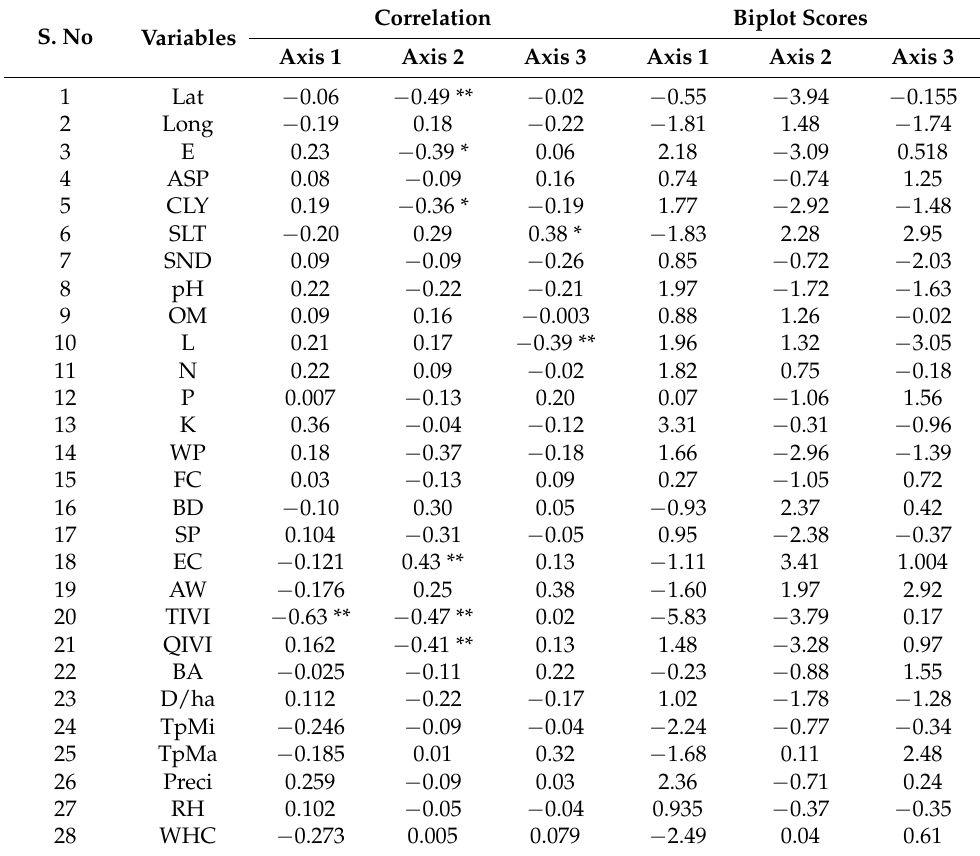
Table 6. Results of the RDA showed correlation coefficients between the physiographic and edaphic variables and the RDA axes and biplot scores of each variable on all the three